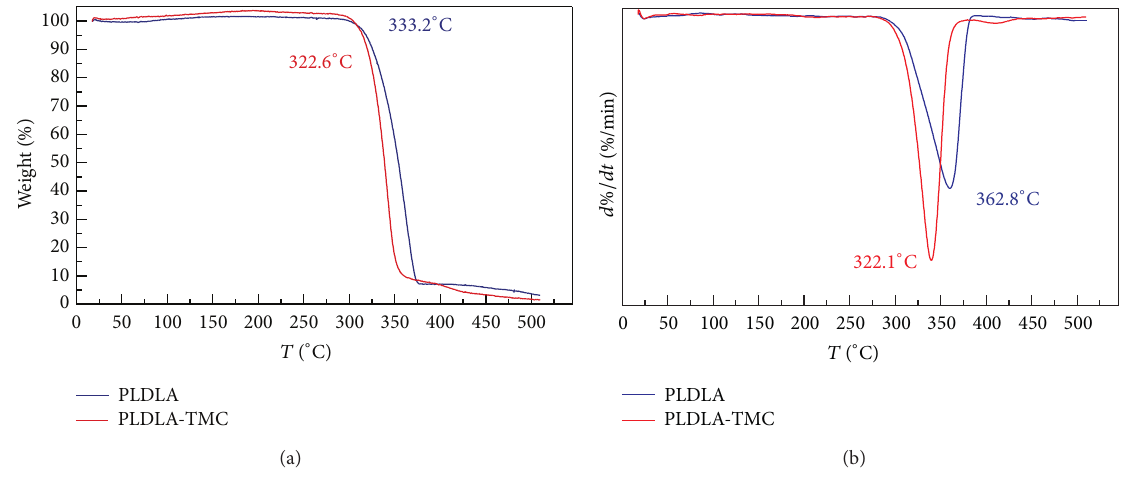
Figure 6: TGA thermograms of PLDLA and PLDLA-TMC scaffolds.